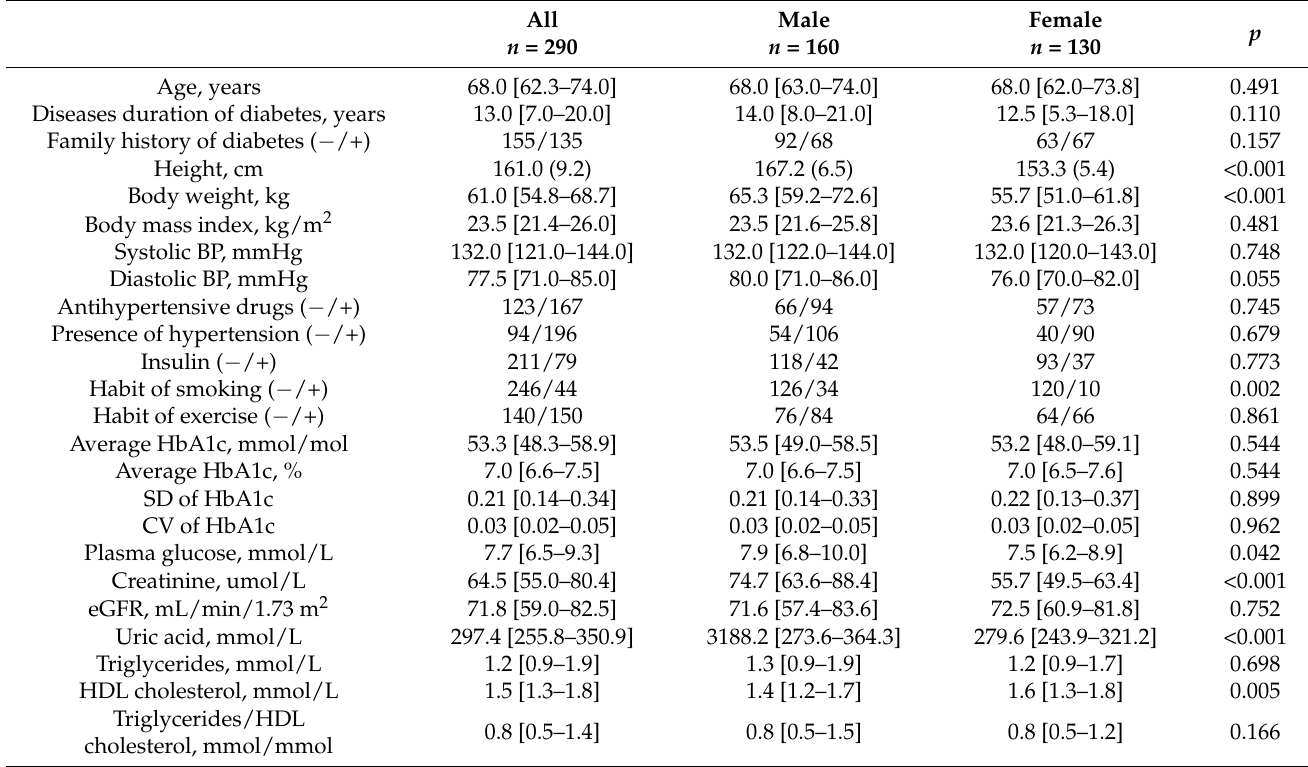
Table 1. Clinical characteristic of study patients.